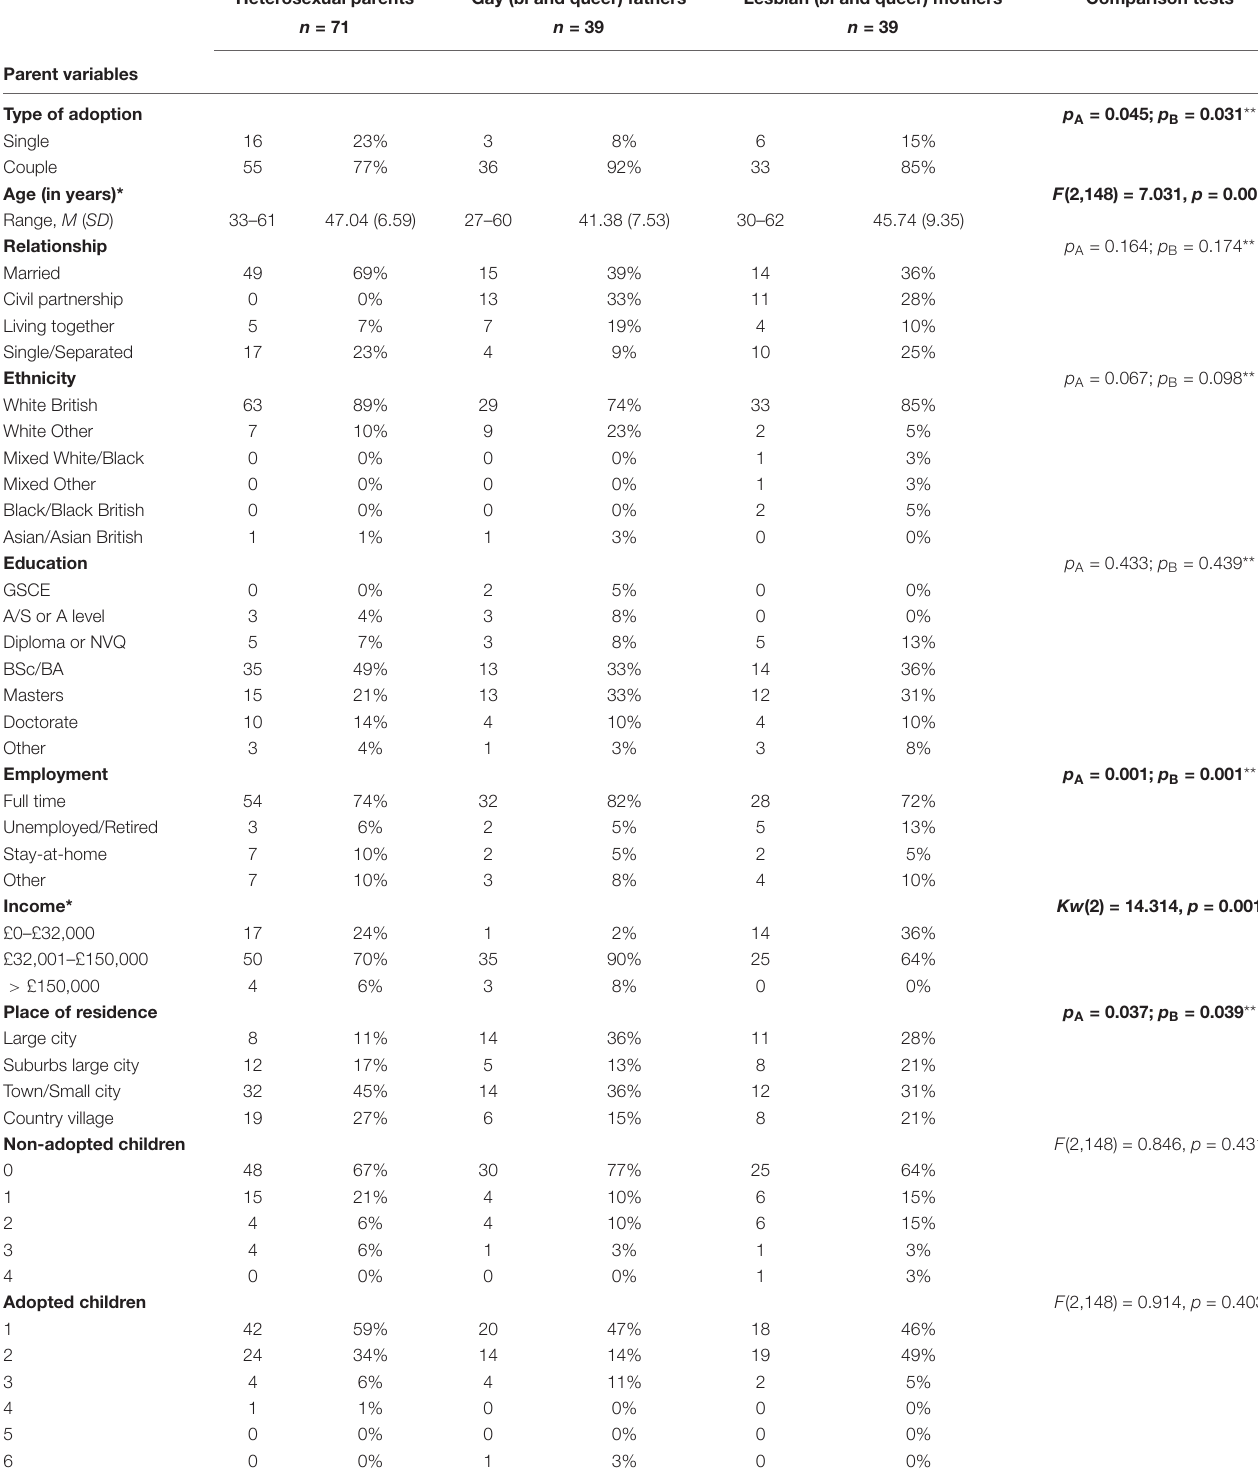
TABLE 1 | Sociodemographic data including parent and children’s main characteristics. Heterosexual parents Gay (bi and queer) fathers Lesbian (bi and queer) mothers Comparison